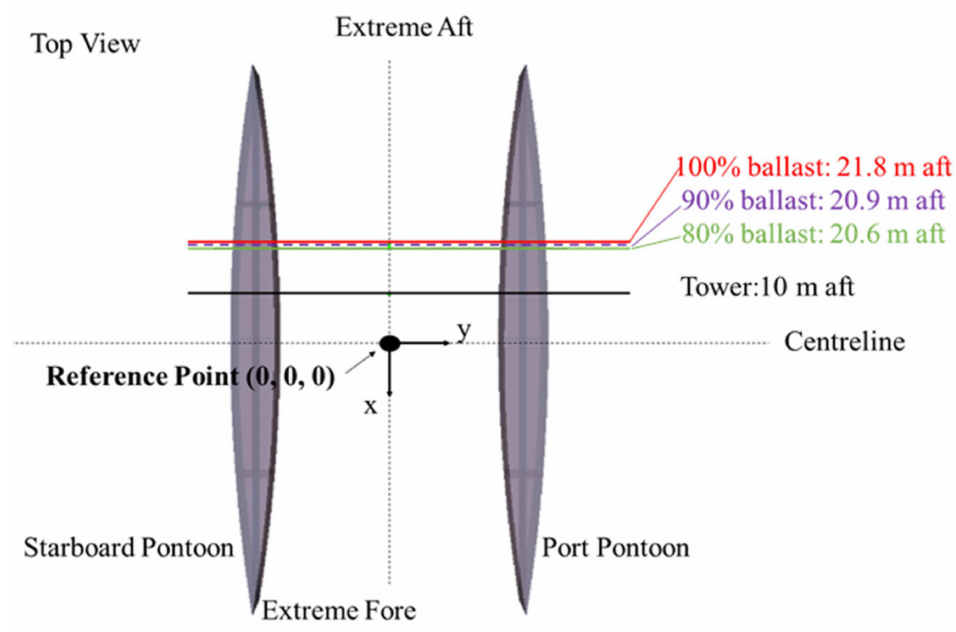
Figure 12. Shift in LCF.